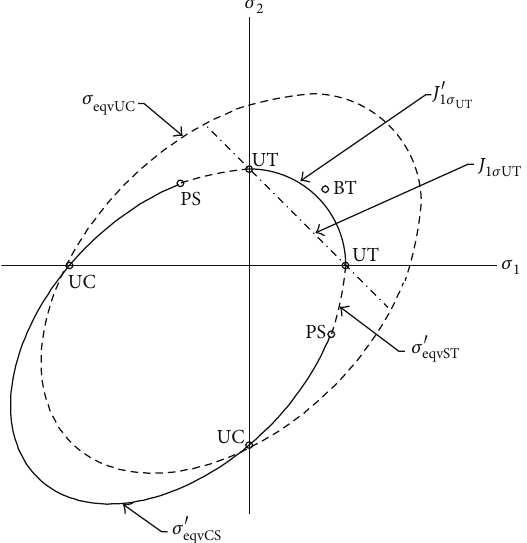
Figure 3: Illustration of failure envelope (plane-stress). UT = uniaxial tensile; BT = biaxial tensile; PS = pure shear; UC = uniaxial = 𝜎 with critical value determined from compression; 𝜎 eqvUC eqv = 𝜎 󸀠 uniaxial compression test; 𝜎 󸀠 with parameters determined eqvCS eqv = 𝜎 󸀠 with from uniaxial compression and shear tests; 𝜎 󸀠 eqvST eqv = parameters determined from shear and uniaxial tensile tests; 𝐽 1𝜎 UT 𝐽 1𝜎 with critical value determined from uniaxial tensile test; and = 𝐽 󸀠 𝐽 󸀠 1𝜎 UT 1𝜎 with critical value determined from uniaxial tensile